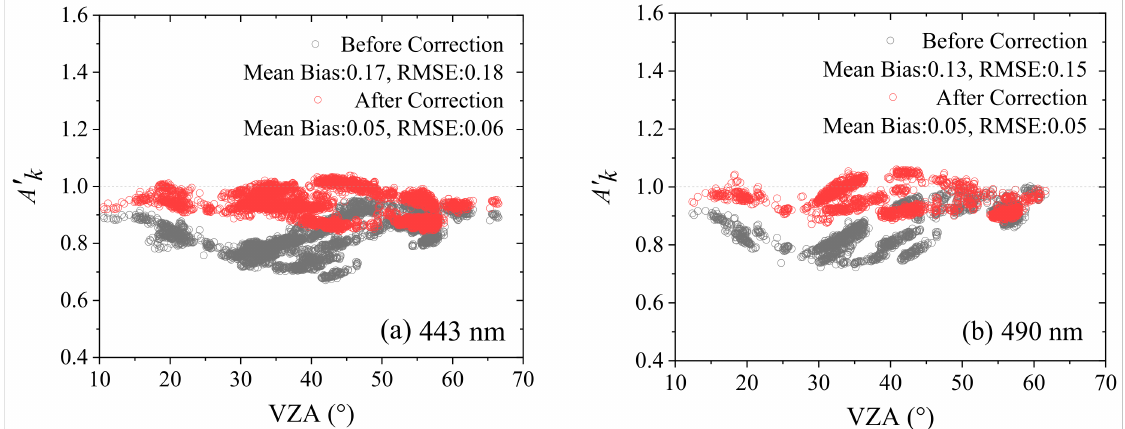
Figure 10. The cross-calibration results of DPC/GaoFen-5 via MODIS/Aqua by using the DPC measurements before and after the radiometric correction. ( a ) 443 nm; ( b ) 490 nm. The mean bias and RMSE represents the difference between A (cid:48)